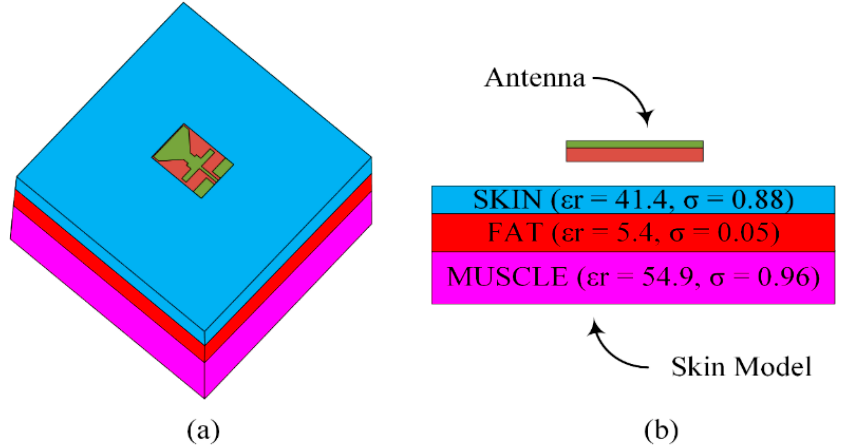
Figure 12. Simulation setup for SAR analysis having an antenna with 3-layered human body model ( a ) perspective view ( b ) side view.